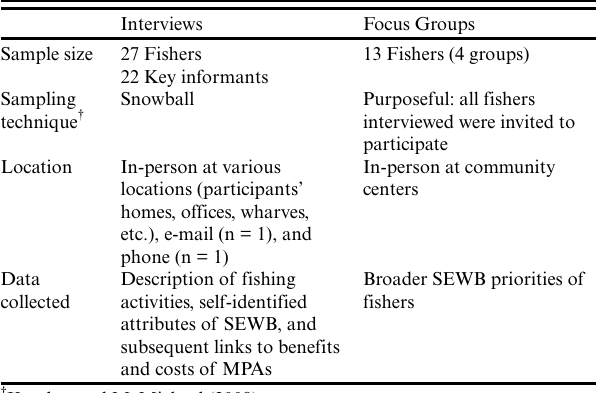
Table 3 . Summary of primary data collection methods. MPA, marine protected area; SEWB, social-ecological